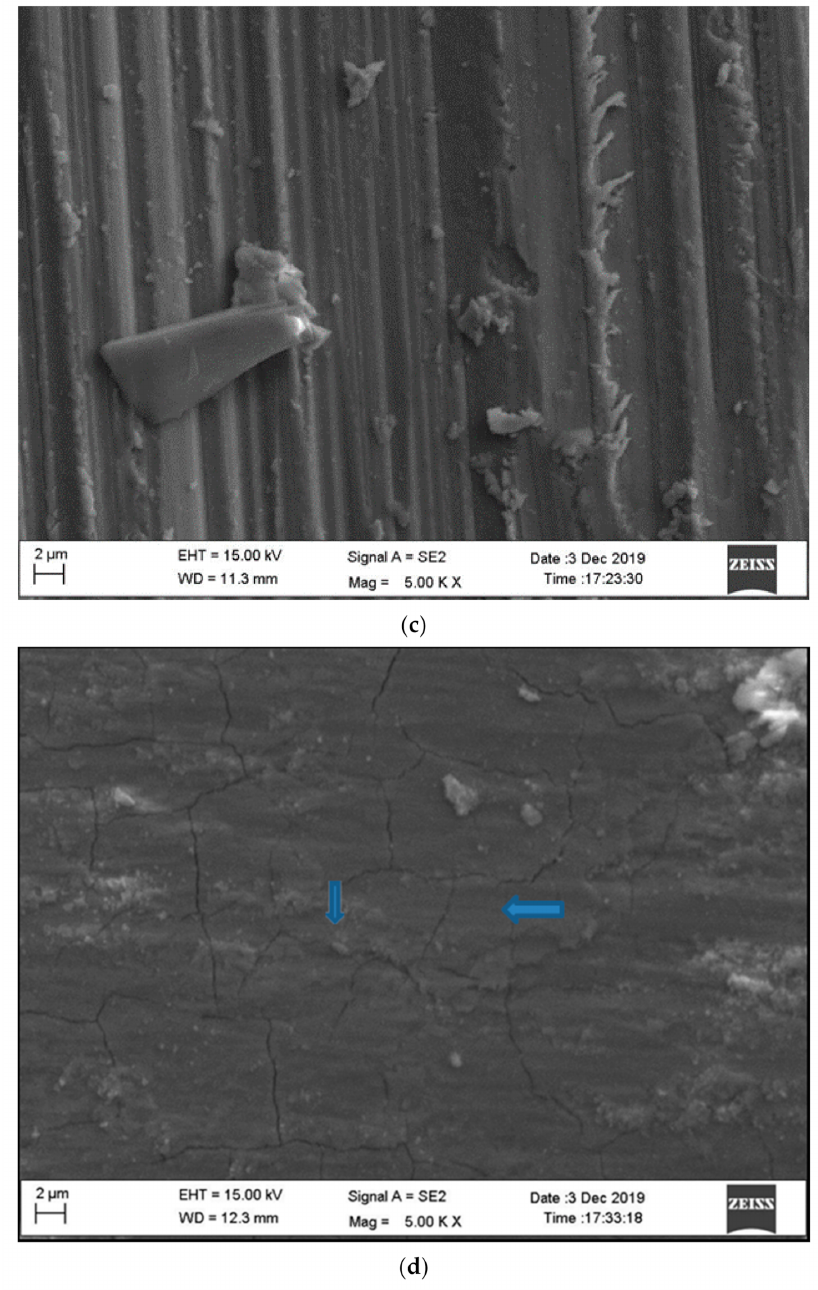
Figure 11. ( a ) SEM image of sintered zirconia surface (control group). ( b ) SEM image of zirconia surface abraded with diamond bur (notable striations with a nonhomogeneous surface). ( c ) SEM image of zirconia surface abraded with modified diamond bur (notable striation following direction of grinding). ( d ) SEM image of zirconia surface abraded with carbide bur (presence of surface